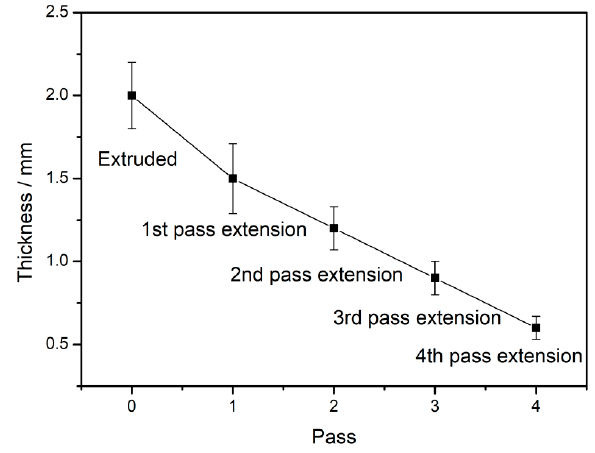
Figure 3. The extruded and four pass extended tubes.